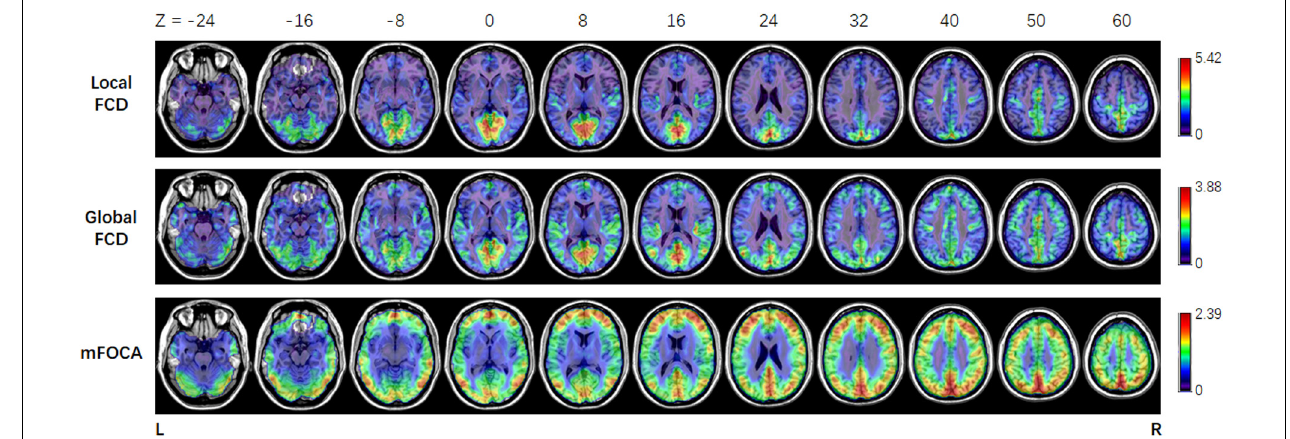
FIGURE 8 | Results of mean normalized local FCD, global FCD and FOCA maps in JME patients.